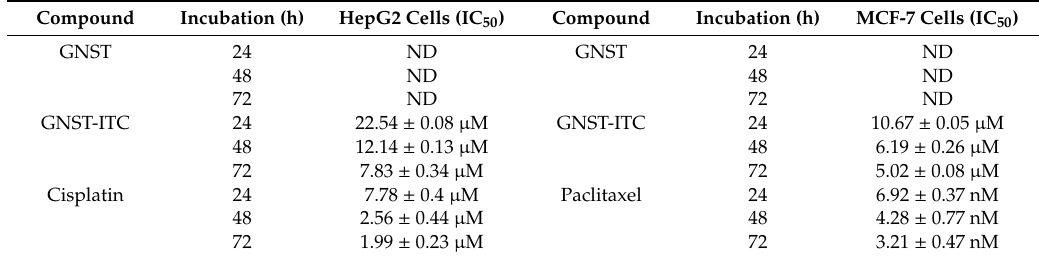
HepG2 and MCF-7 cells were incubated with GNST (0.1–100 µ M) with and without the presence of myrosinase for 24, 48, and 72 h of incubation. Cisplatin and paclitaxel served as the positive control. Results are presented as mean ± SD for triplicate determinations. ND: not